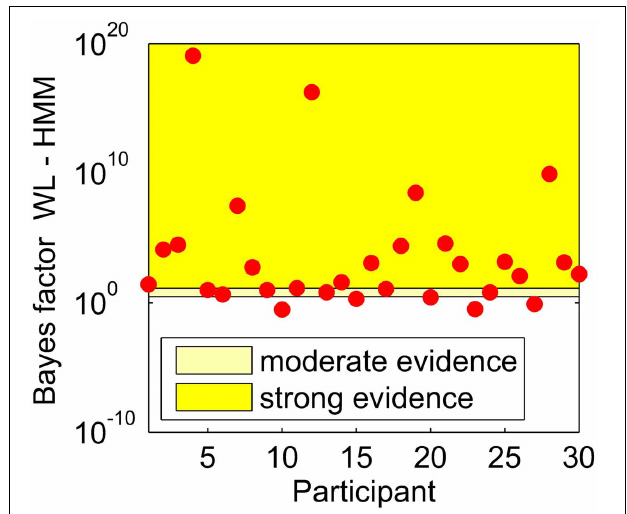
FIGURE 2 | Bayes factors for the difference between the WL and HMM models, calculated for each participant shown by a red circle.